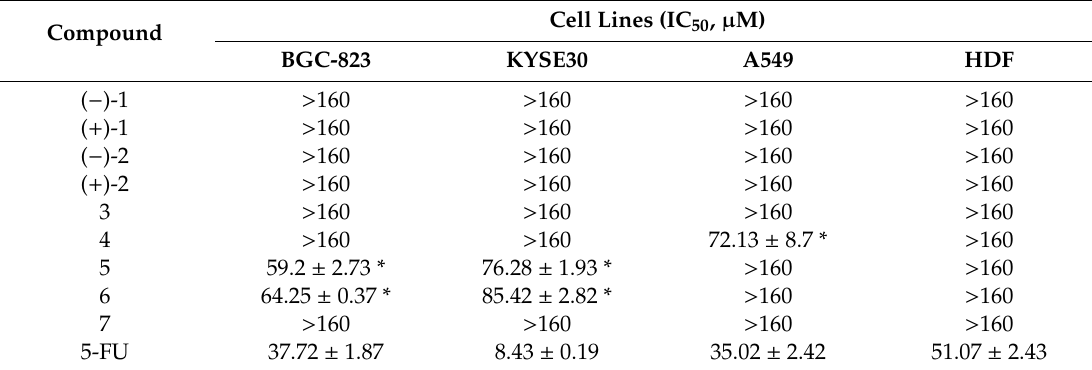
Table 4. IC 50 values for 1 – 7 and 5-FU on di ff erent cell